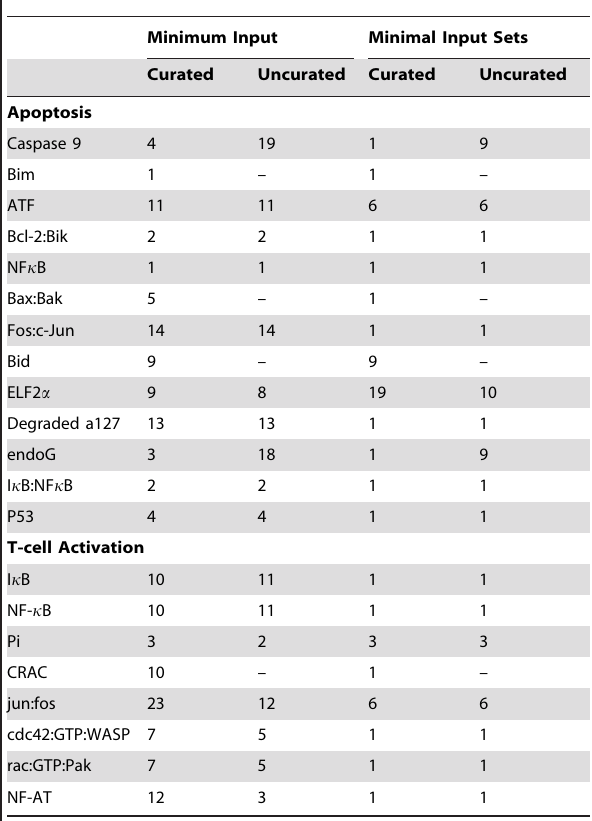
Table 3. Analysis of Panther Pathways